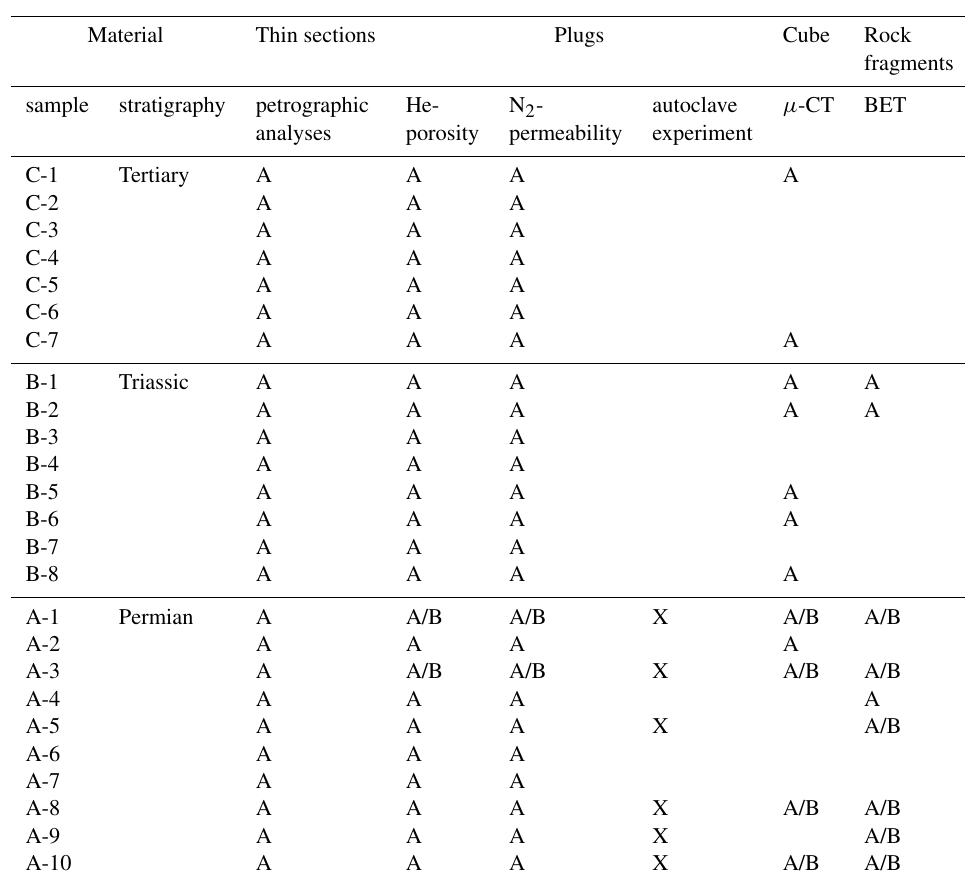
Table 2. Sample overview and methods used for the presented data (A represents single analyses, B represents repeated method after CO 2 autoclave experiments with the same sample; X is outlining the samples used for these